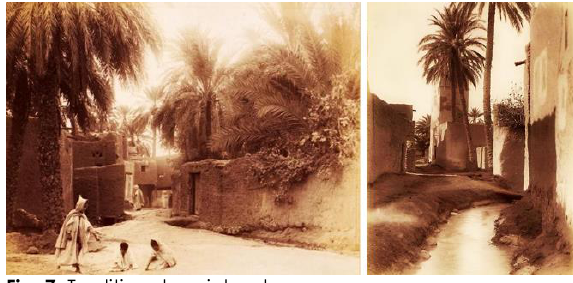
Fig. 7. Traditional oasis